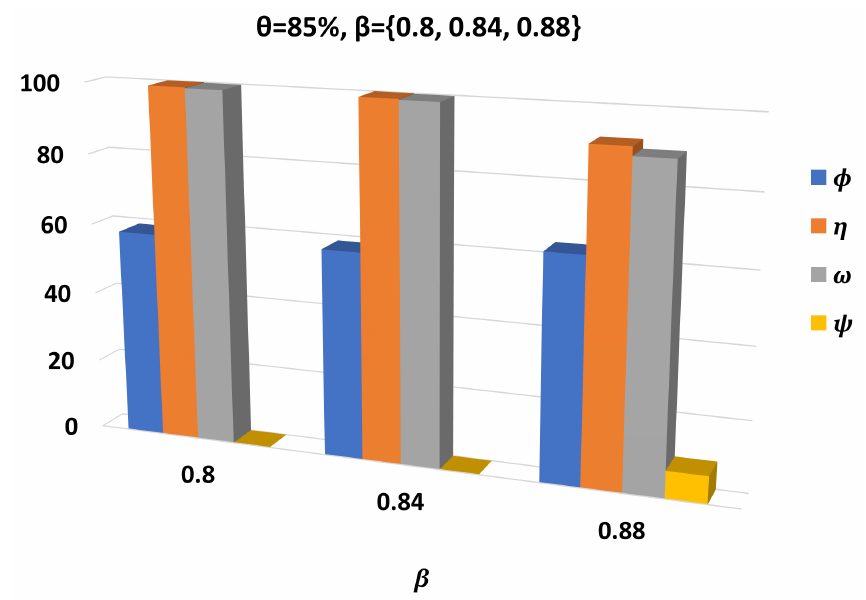
Figure 7. Comparison of UPSHM performances for all metrics for different values of β